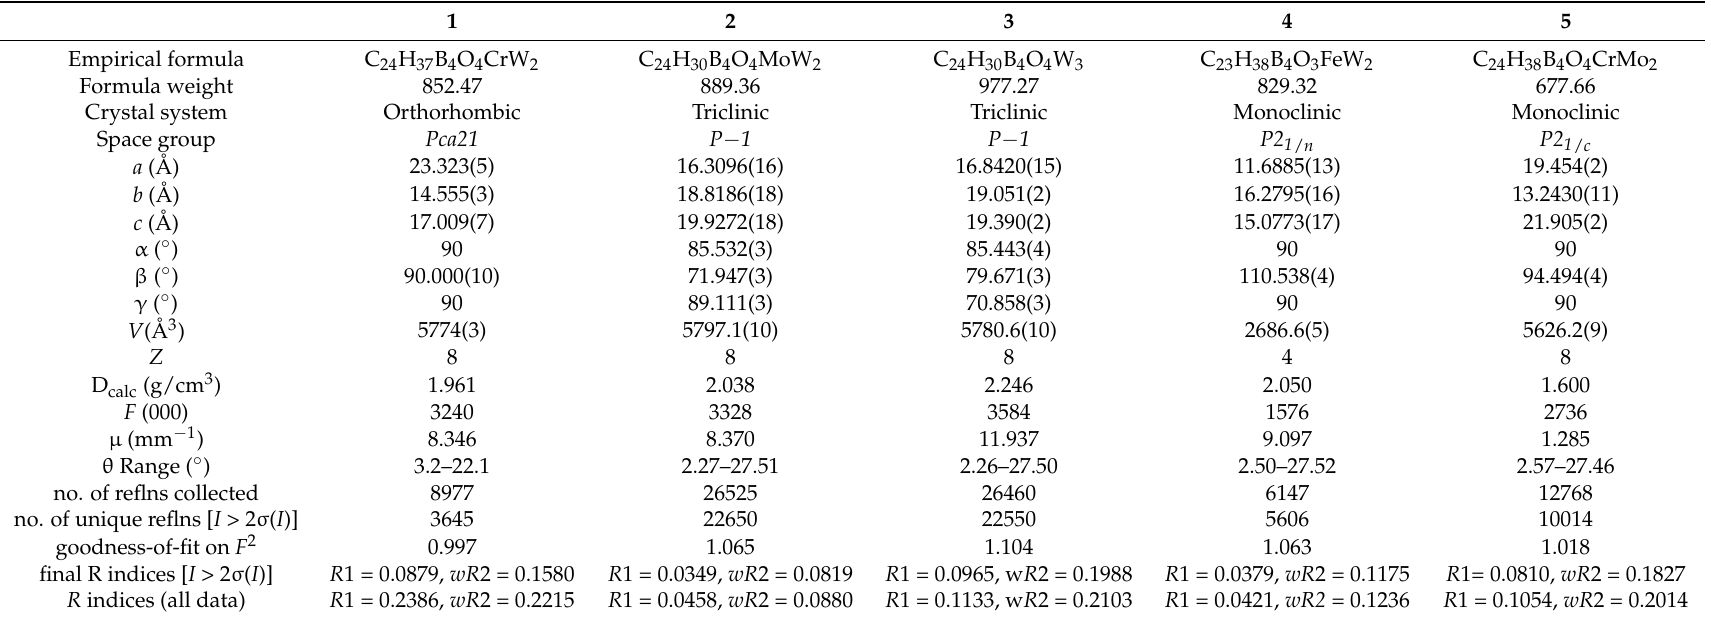
Table 3. Crystallographic data and structure refinement information for 1 – 5